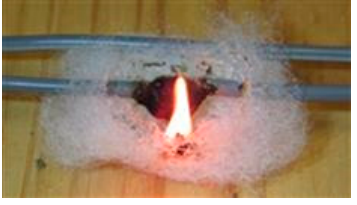
Figure 13. Ignition of combustibles.